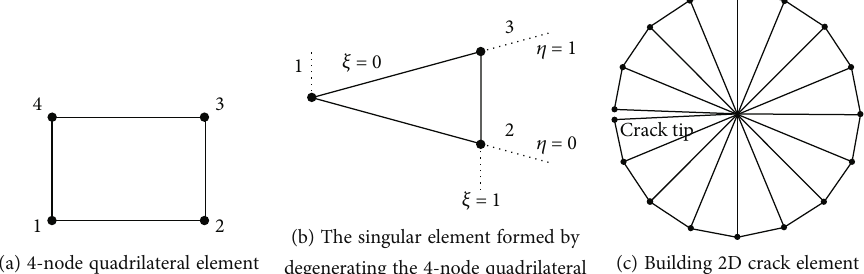
Figure 1: Singular element and 2D crack element.